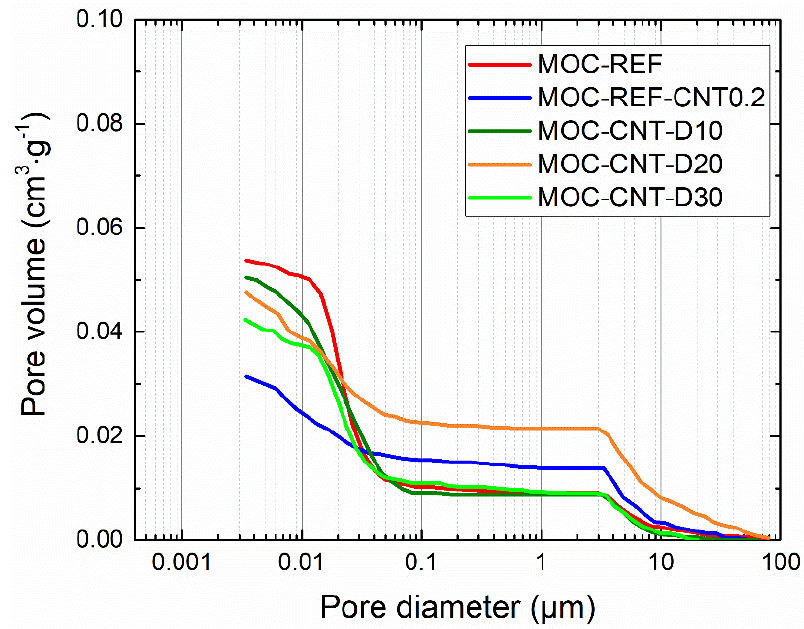
Figure 7. Cumulative intruded pore volume.